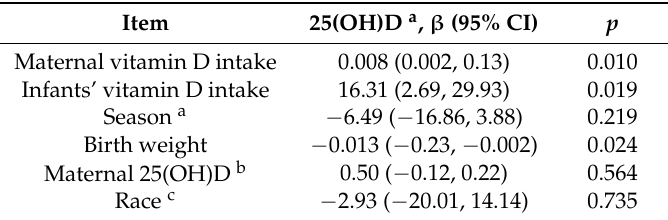
Table 3. Multiple regression model for 25(OH)D of